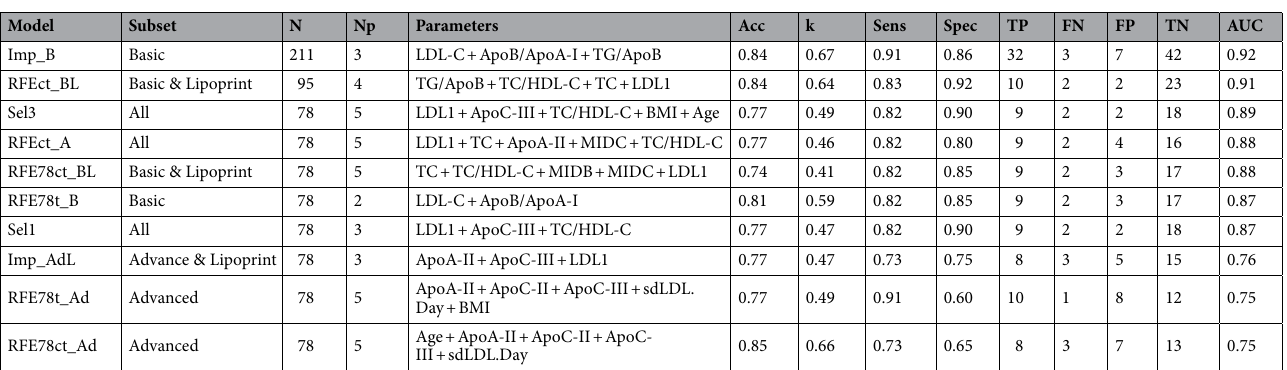
Table 2. Top ranking models and performance. N number of individuals, Np number of parameters, Acc accuracy, k Cohen’s kappa coefficient, Sens sensitivity, Spec specificity, TP number of true positives, FN